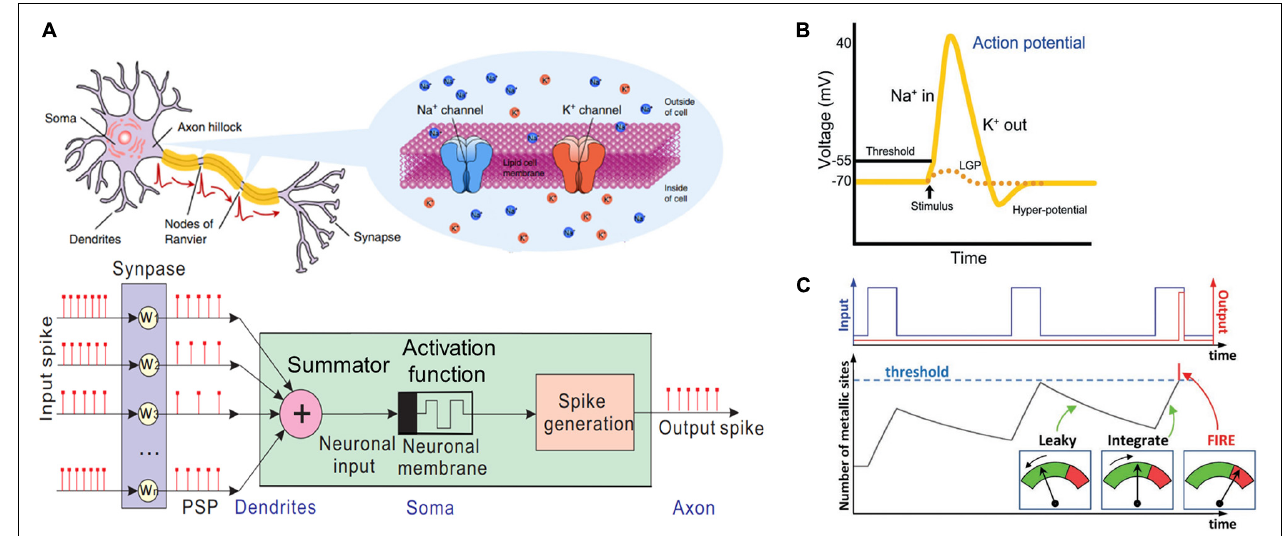
FIGURE 1 | (A) Schematic of a biological neuron and an equivalent artificial neuron (Yi et al., 2018). (B) Diagram of membrane potential in the Hodgkin–Huxley (HH) model. (C) Schematic of the leaky integrate-and-fire (LIF) model (Stoliar et al.,